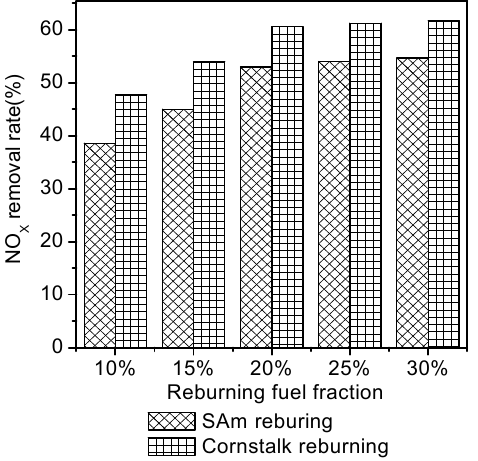
Figure 8. NO x removal rate under different R ff